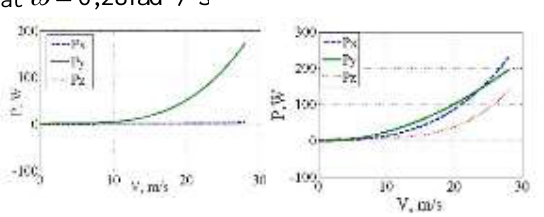
Figure 3. D iagrams of dependence useful Py and adverse Px, Pz of aerodynamic power from the incoming flow rate